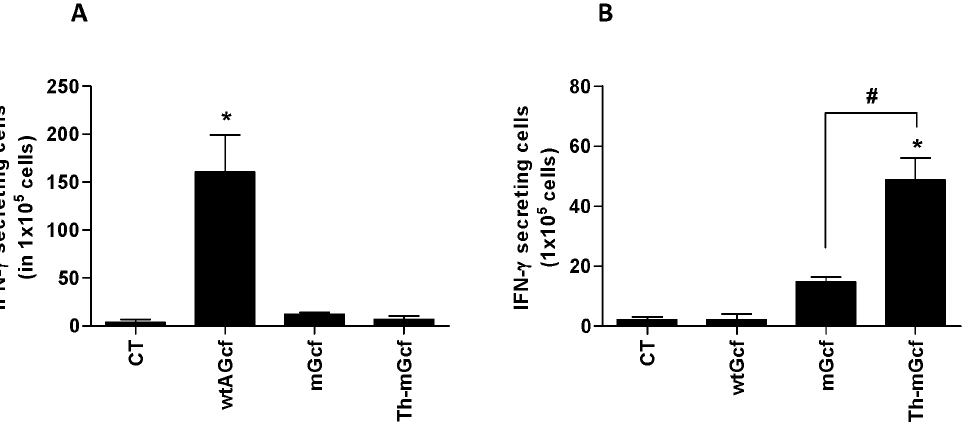
Figure 5. T cell response by modified Gcf. Mice was immunized twice with Gcfs sublingually or FI-RSV through foot-pad route and then challenged with RSV A2 three weeks after the second immunization. At day 4 post-challenge, lung mononuclear cells were prepared from the lung tissue and re-stimulated with (A) G (a.a. 183–195) or (B) F (a.a. 51–66) peptide. T cell responses were detected as IFN- c secreting cells by ELISPOT. The results are expressed as means + S.E.M. for the group (n=3). The data are representative of two separate experiments. Significant differences from results with the CT are marked with asterisks (*), while significant differences between mGcf and Th-mGcf are marked with sharp ( # ), respectively (* or # , P , 0.05)